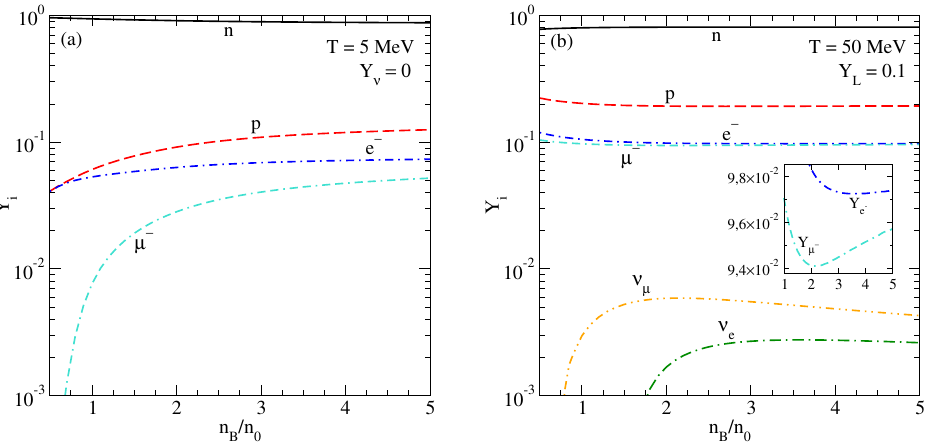
Figure 1. Composition of neutron star merger matter in the DDME2 model, in neutrino-transparent regime with T = 5 MeV ( a ) and neutrino-trapped regime with T = 50 MeV ( b ). The inset shows the minima in the electron and µ -on fractions, at which the subsystems of electrons and muons are scale-invariant, and the corresponding partial bulk viscosities vanish.